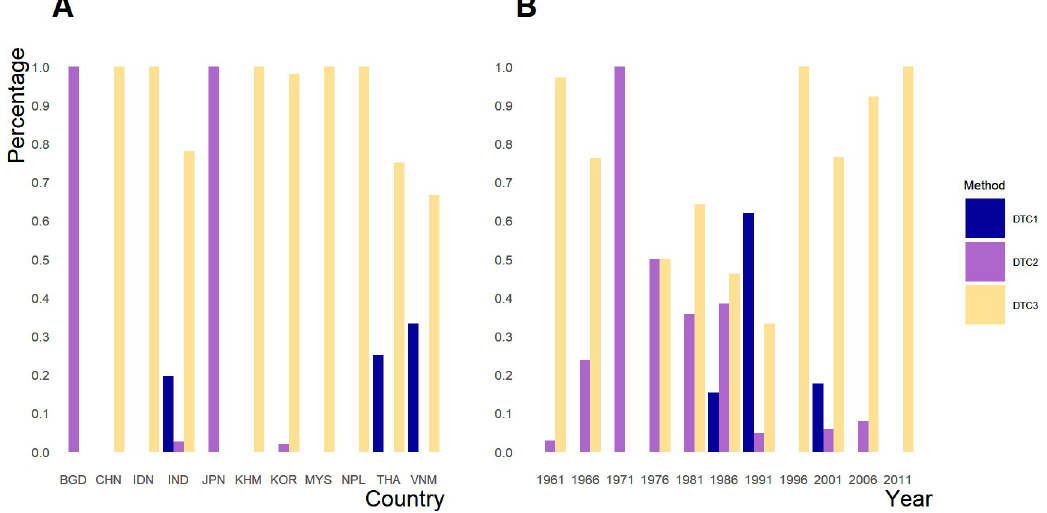
Fig 2. Distribution of Japanese encephalitis (JE) diagnostic methods used by collated JE case-fatality ratio (CFR) records with clear case definition by geographical locations (Panel A) and time (Panel B). DTC is the abbreviation of diagnostic testing category. The colors represent each method, with dark blue for cases confirmed by virus isolation, antigen or pathogen detection (DTC1), purple for cases confirmed by detection of neutralization antibody in cerebrospinal fluid (CSF) or serum (DTC2), and yellow for cases consistent with WHO JE case definition: JE Immunoglobulin M (IgM) antibody in CSF or serum as confirmed by MAC-ELISA on patients with acute encephalitis syndrome (DTC3). Only the diagnostic methods for laboratory confirmed JE cases collected from studies in our analysis were